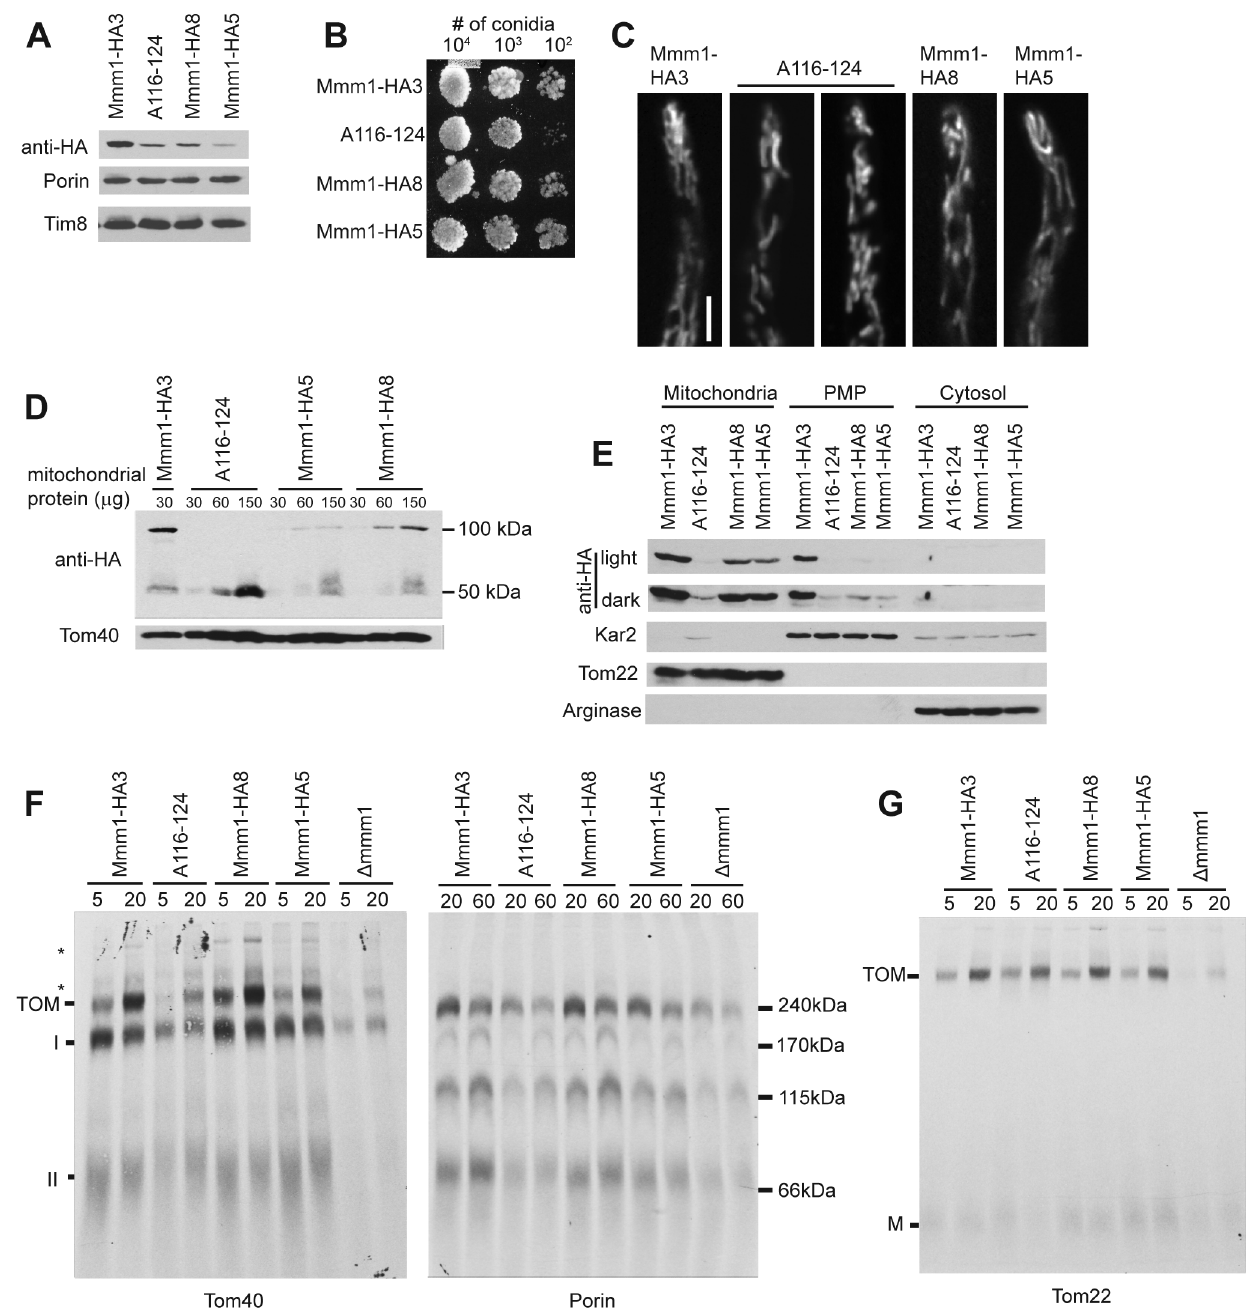
Figure 5. Characterization of N.crassa Mmm1 conserved region mutant A116-124. A. Western blot analysis of crude mitochondria (30 ug) from the indicated strains. Samples were subjected to SDS-PAGE, transferred to nitrocellulose and analyzed by Western blotting for the indicated proteins. B. Measurement of growth as in Figure 3C. C. Confocal microscopy of mitochondria as in Figure 3D. D. Non-reducing SDS-PAGE followed by Western blot analysis as in Figure 3E, but 30, 60, and 150 m g of mitochondria isolated from the indicated strains were loaded. E. Cell fractionation as in Figure 1A. F. Assembly of radiolabeled b -barrels as in Figure 4A using crude mitochondrial preparations as indicated in the Methods. G. Assembly of radiolabeled Tom22 as in Figure 4C.